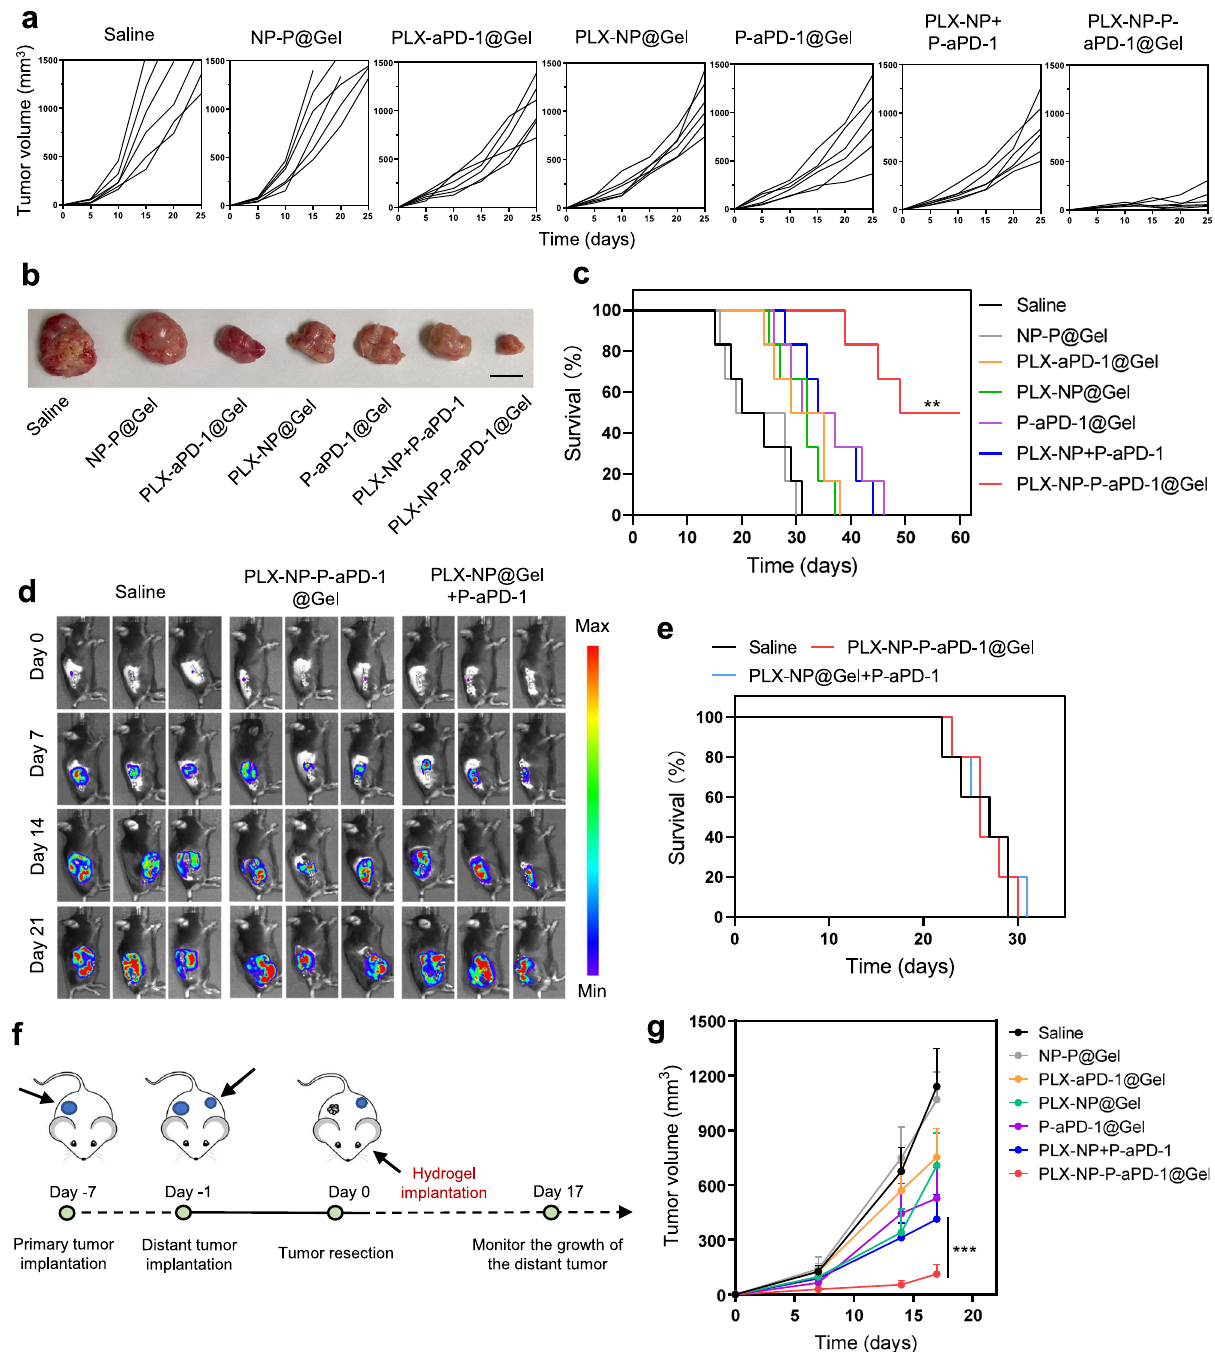
Fig. 6 Evaluation of in vivo treatment ef fi cacy of PLX-NP-P-aPD-1@Gel in different tumor recurrence models including the sarcoma S180 tumor model and B16F10 melanoma model in T cell-de fi cient mice. a Tumor growth curves among different treatment groups in sarcoma S180 tumor recurrence model ( n = 6 mice). Saline; NP-P@Gel, blank nanoparticles and unmodi fi ed platelets co-loaded hydrogel; PLX-aPD-1@Gel, free PLX and aPD-1 co-loaded hydrogel; PLX-NP@Gel, PLX-NP loaded hydrogel; P-aPD-1@Gel, P-aPD-1 loaded hydrogel; PLX-NP + P-aPD-1, free PLX-NP and P-aPD-1; PLX-NP-P-aPD-1@Gel, PLX- NP and P-aPD-1 co-loaded hydrogel. The doses of PLX and aPD-1 were 5 mg/kg and 0.1 mg/kg, respectively. b The images of representative tumors after different treatments on day 21 ( n = 6 mice). c Survival curves of the mice in different treatment groups in the S180 tumor recurrence model ( n = 6 mice). Data were analyzed with Log-rank (Mantel-Cox) test, PLX-NP-P-aPD-1@Gel vs. PLX-NP + P-aPD-1: ** P = 0.0031. d Representative bioluminescence images of B16F10 tumor-bearing Rag − / − mice following different treatments on day 0, day 7, day 14, day 21 ( n = 5 mice). e Survival curves of the mice treated with different treatment groups in B16F10 tumor recurrence model in Rag − / − mice ( n = 5 mice). f Schematic illustration of the establishment and treatment strategy of a double tumor model. g Tumor growth curve of the distant tumor after different treatments (PLX-NP-P-aPD-1@Gel vs. PLX-NP + P-aPD-1: *** P < 0.0001). Data are presented as mean ± s.d. ( n = 6 mice) and analyzed with two-way ANOVA followed by Tukey ’ s multiple comparison test. Source data are provided as a Source Data fi